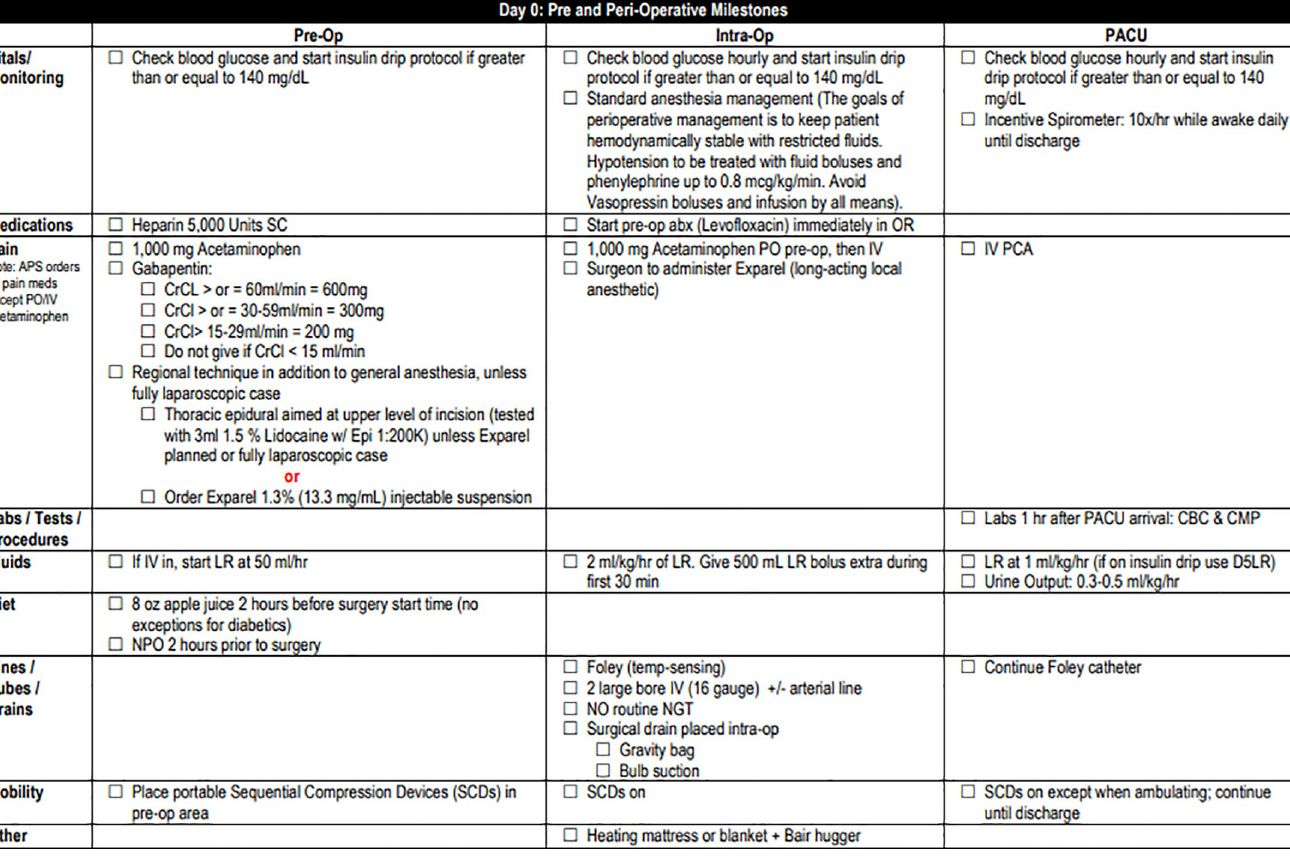
Fig 2. Whipple Intra-operative